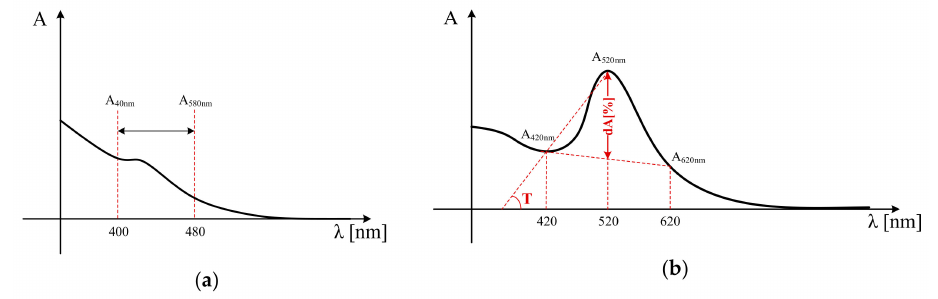
Figure 7. Qualitative plot of a typical absorption spectrum for: ( a ) white wines, and ( b ) red